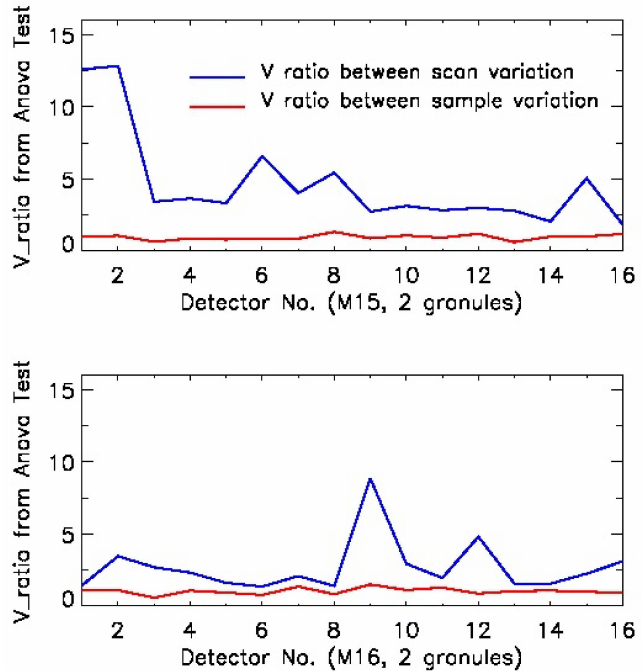
Figure 14. V ratios (defined in Equation (16)) from ANOVA tests for SD radiance HAM side ratio for 16 detectors in M15 ( top ) and M16 ( bottom ) for two granules on 30 June 2015. The cumulative histogram method discussed in Section 4.1 (Equations (7) and (8) can also be used for SD radiance to show detector-to-detector variation. The cumulative histogram of SD